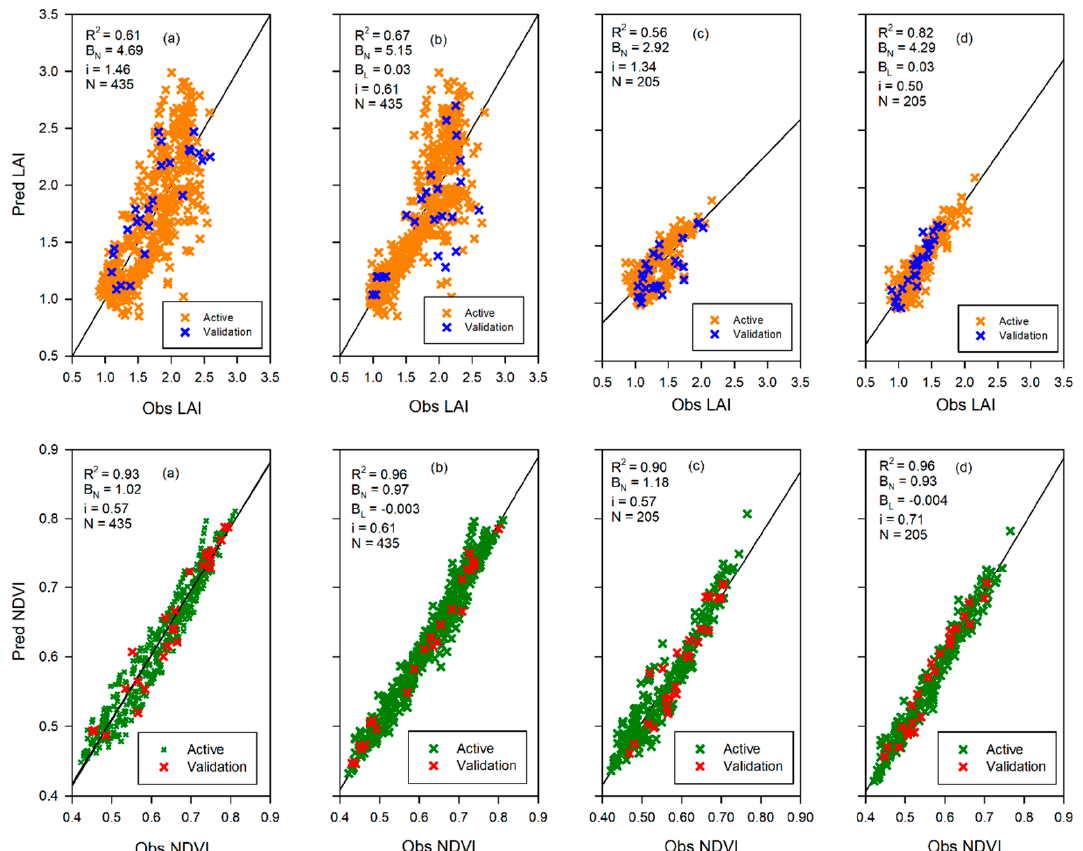
Figure 6. First row : Plots of the CCR.LM results at annual scale (January–December) ( a , b ) and dry season (May–October) ( c , d ): LAI regression graphs at annual scale ( a ) with NDII as only predictor variable and ( b ) with LST and NDII used simultaneously as predictors. LAI regression graphs during the dry season ( c ) with NDII as only predictor variable and ( d ) with LST and NDII combined as predictor variables. Second row: Plots of the CCR.LM results at annual scale (January–December) ( a , b ) and dry season (May–October) ( c , d ): NDVI regression graphs at annual scale ( a ) with NDII as only predictor variable and ( b ) with LST and NDII combined as predictors. NDVI regression graphs during the dry season ( c ) with NDII as only predictor variable and ( d ) with LST and NDII used simultaneously as predictor variables. R 2 = coefficient of determination, B N = unstandardized coefficient of estimate with the NDII, B L = unstandardized coefficient of estimate with the LST, i = intercept, N = number of observations.